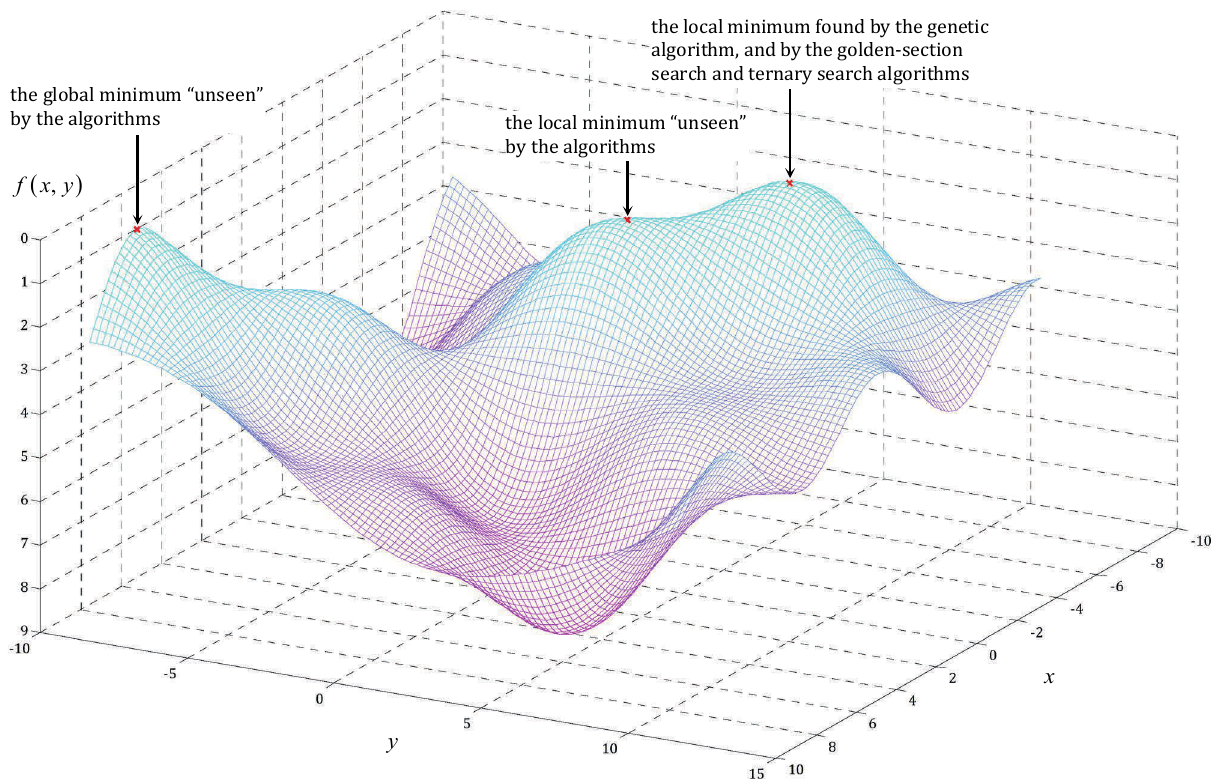
Fig. 2. An example of when none of the algorithms “sees” the global minimum, but each of the algorithms found the same local minimum omitting another local minimum whose surface value is greater (the surface value axis is shown in reverse direction for easier observation of